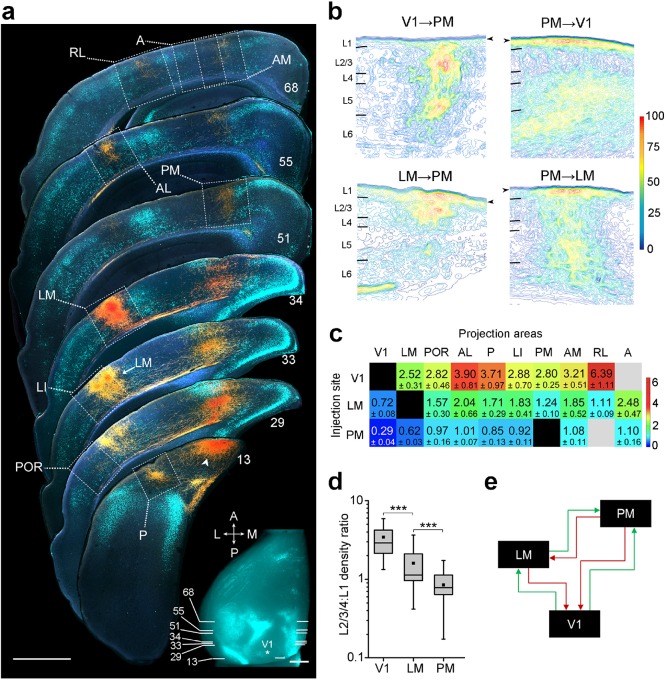
Hierarchy between V1, LM, and PM.(a) Rostrocaudal series of coronal slices through the left hemisphere showing anterogradely labelled axonal projections (yellow/orange) after V1 was injected with BDA. Retrogradely labelled callosally projecting neurons (light cyan), upon injection of bisbenzimide in the right hemisphere, act as landmarks for identification of areas (Wang and Burkhalter, 2007). Numbers denote sections corresponding to the positions shown in inset. See Figure 1—figure supplement 1 for higher magnification of areas within dotted squares. Projection to LM adjacent to LI in section 33 is indicated. Arrowhead indicates a region in V1 near the injected site. In situ image of retrograde bisbenzimide-labelled callosally projecting neurons in the left hemisphere. Injection site in V1 (asterisk) and positions of coronal slices shown above are indicated. Scale bars, 1 mm. (b) Optical density of axonal projections in the target areas of the indicated pathways, normalized to peak density. Contours connect regions with similar optical densities. Arrowheads denote the edge of the slice and edge artifacts due to interpolation of optical density with dark background. (c) Color-coded heat map of L2-4:L1 density ratio (DR) for each of 25 distinct cortico-cortical connections. Blocks in grey indicate projections that were too weak to analyze. V1 exhibits the highest DRs, and PM the lowest, indicating the relative hierarchical positions of the areas. (d) The mean DR for all target areas is highest for V1, intermediate for LM, and lowest for PM; ***p<0.001, Mann-Whitney U-test. (e) Our schematic interpretation of the hierarchy of V1, LM, and PM in visual processing. Feedforward pathways are denoted in green, feedback in red.